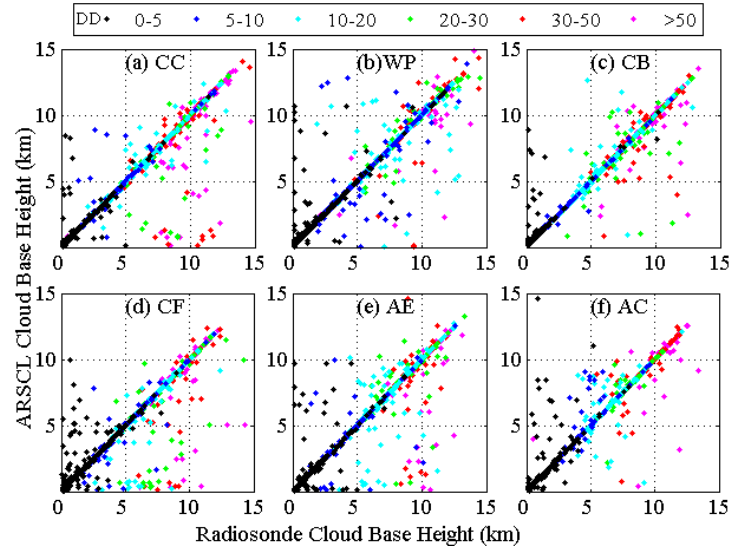
Figure 7. Comparison of collocated cloud-base heights derived from the radiosonde and ARSCL data in the synoptic patterns of: CC ( a ); WP ( b ); CB ( c ); CF ( d ); AE ( e ); and AC ( f ) during 2001–2010 at the SGP site. Colored dots in each panel represent different radiosonde drift distances (DD; units in km).